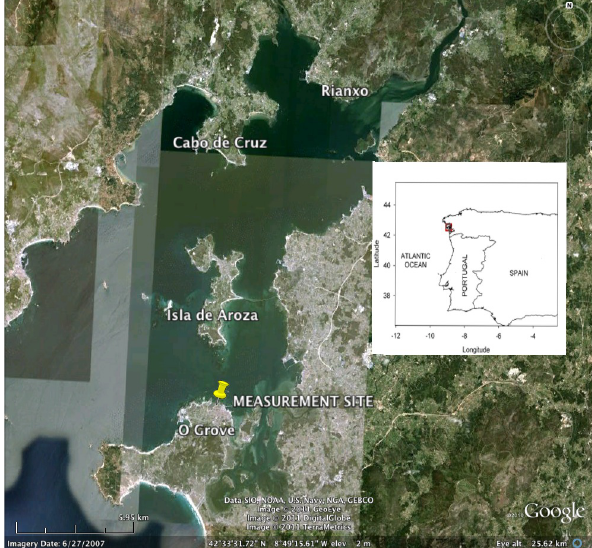
Fig. 1. Location of the measurement site during the LEGOLAS study. There is macroalgae bed 30–50m wide adjacent to the site within the inter-tidal zone. A similar bed occurs along the south coast of the island of Isla de Arosa (3.5km). Information about macroalgal distribution to the north of the bay near Cabo de Cruz (15–20km) was not available. Image from Google